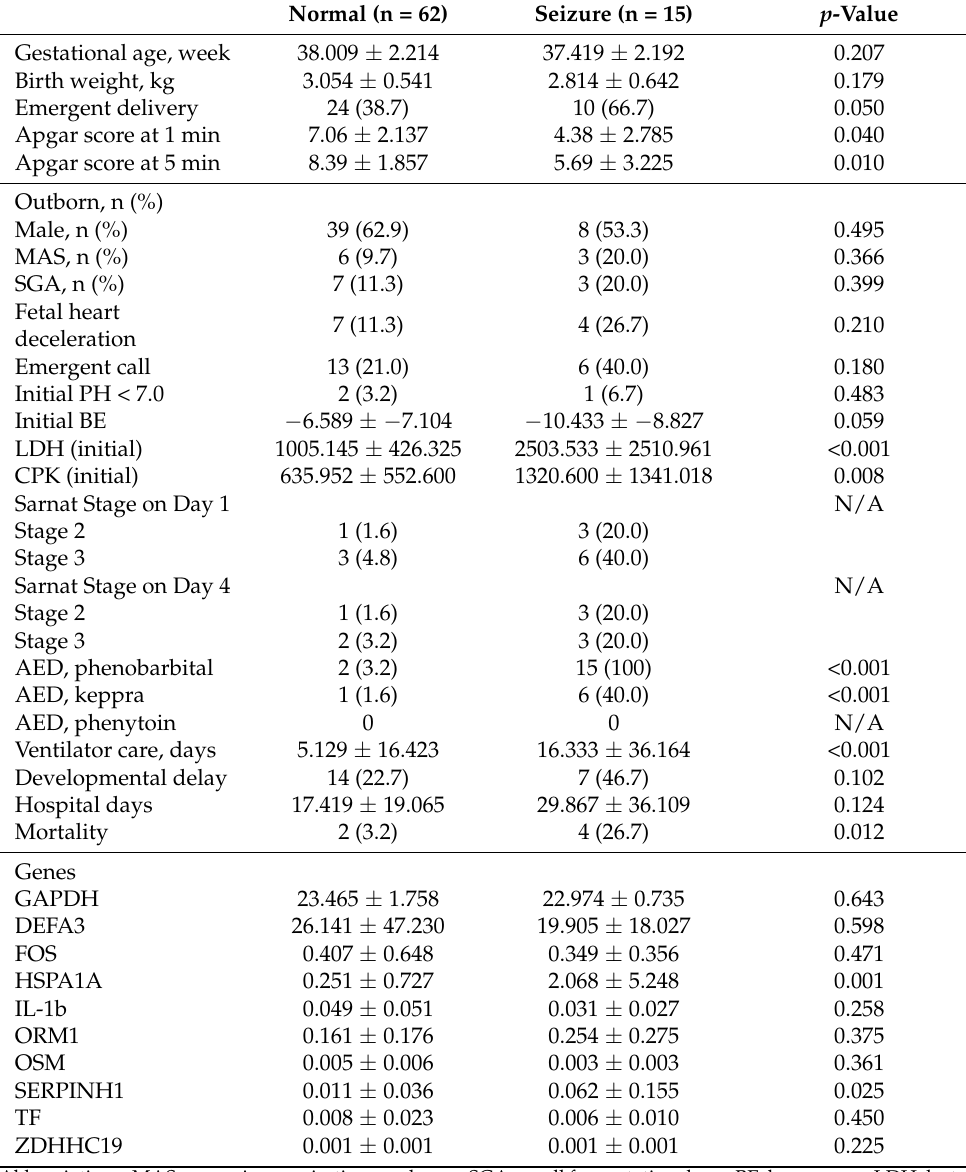
Table 2. Significant clinical findings in clinical seizure infants (n =